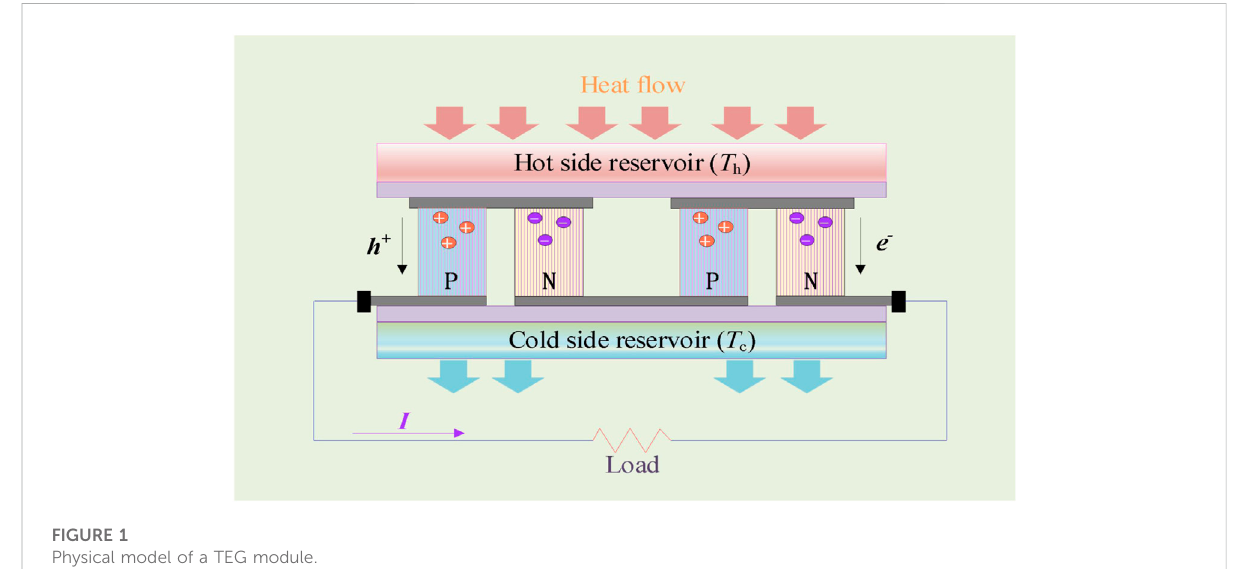
FIGURE 1 Physical model of a TEG